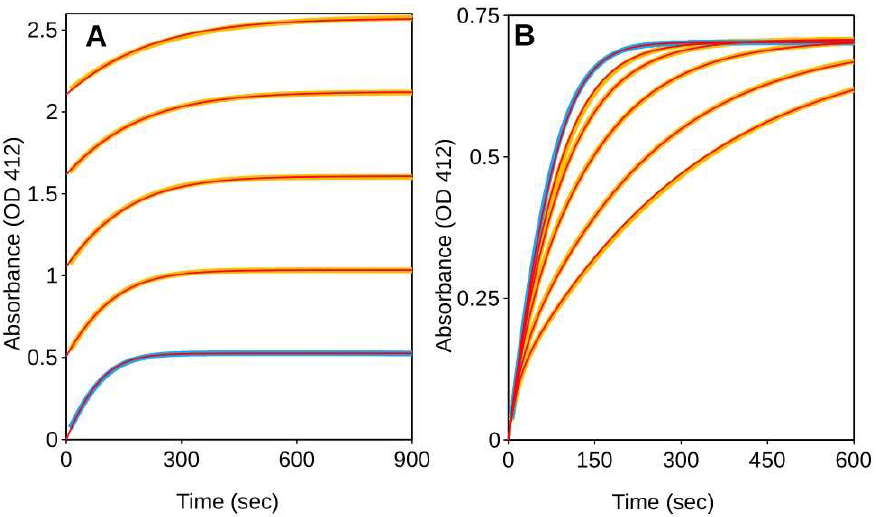
Figure 6. Kinetic analysis of progress curves . Time course of product formation for ATCh and Tc AChE in the absence (blue trace) or presence (yellow traces) of the inhibitor. The red lines are from fitting the kinetic parameters to the corresponding experimental data. ( A ) Determination of k at / K m , K cat and of the K i for product inhibition. Five subsequent reactions were measured in the same cuvette with 200 pM of Tc AChE and 35 µM of ATCh. Once the substrate was completely converted to thiocholine-TNB, a new reaction was started by adding further 35 µM of ATCh. Four initial concentrations of thiocholine-TNB were tested (from 35 to ~150 µM). At higher thiocholine-TNB initial concentration the plateau is reached at longer reaction times, which indicates product inhibition. ( B ) Determination of GAL inhibition. Tc AChE was 200 pM, ATCh 50 µM and GAL concentrations were 0 (blue trace), 15, 30, 60, 120 and 180 nM (yellow traces).